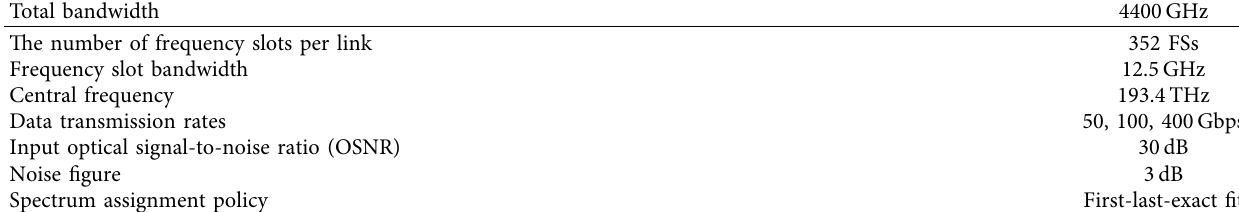
Table 4: Te network parameters used in simulations.